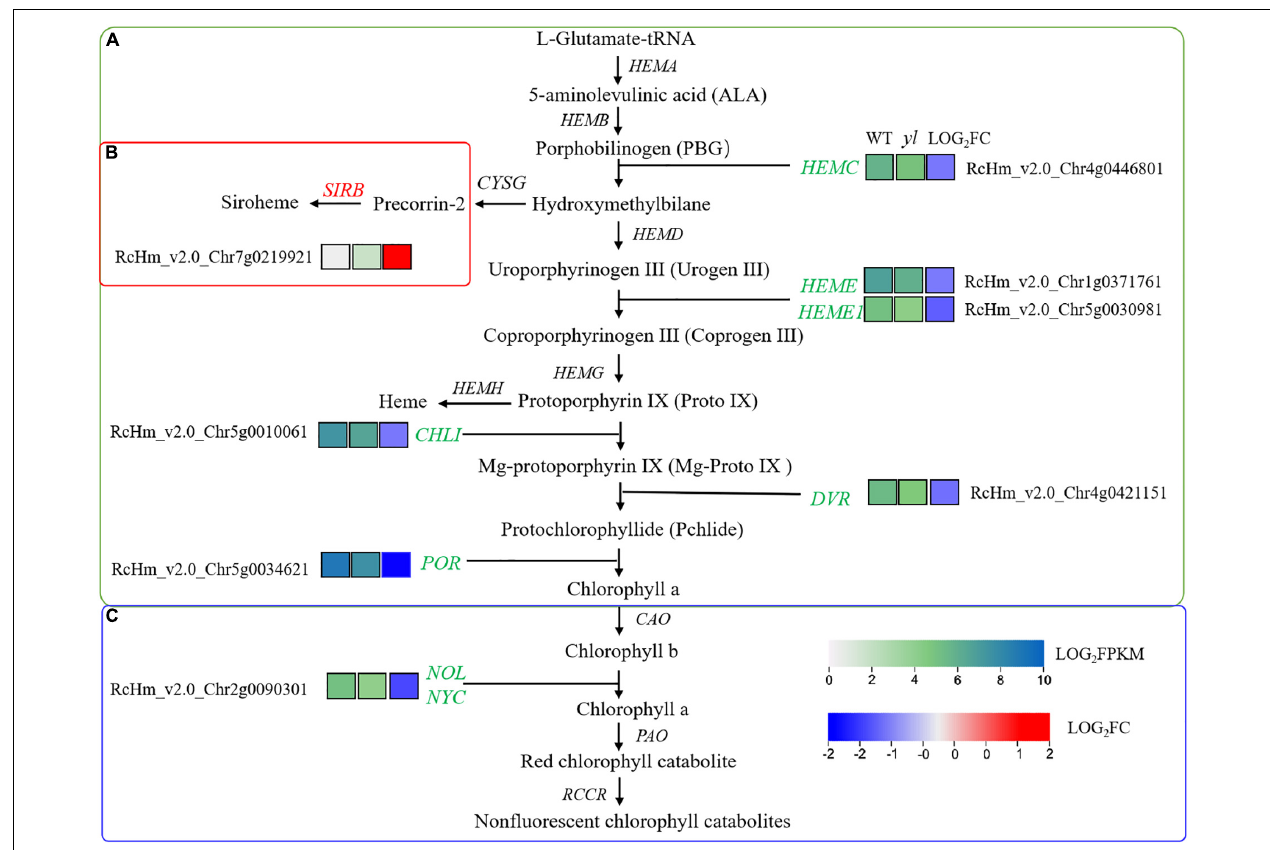
FIGURE 6 | Differentially expressed genes (DEGs) involved in chlorophyll biosynthesis. (A) Chlorophyll biosynthesis pathway. (B) Siroheme biosynthesis pathway. (C) Chlorophyll degradation pathway. SIRB, siro hydro chlorin